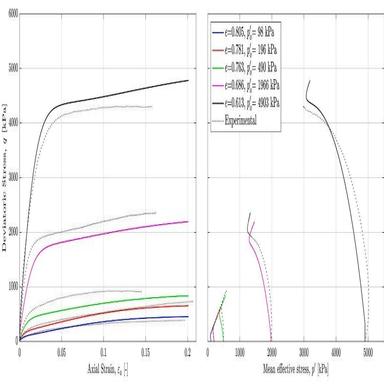
El Torito tailings sand. Simulation compared with experiments in undrained triaxial tests based on Solans and Maureira.